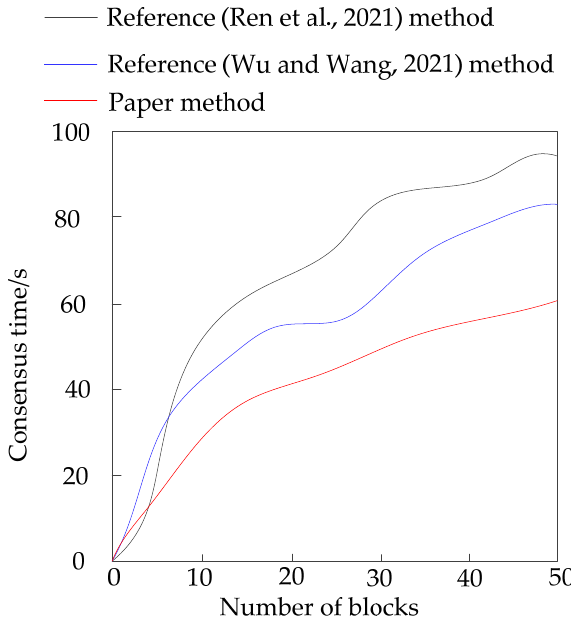
Figure 9. Success probability of data tampering by different methods [6, 7].